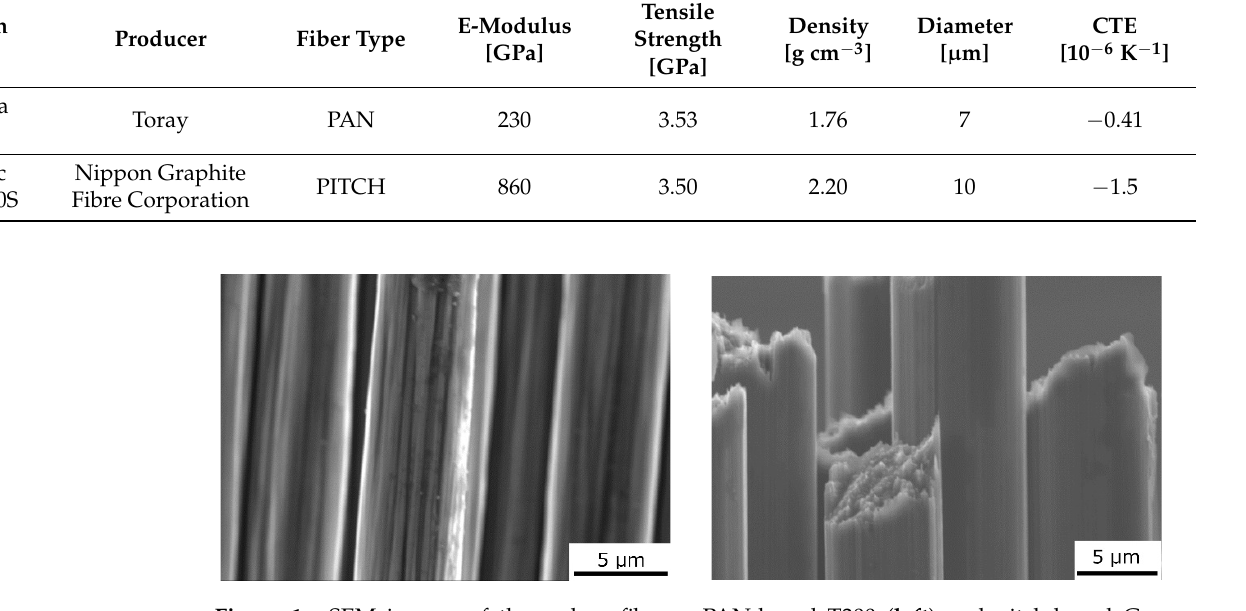
Figure 1. SEM images of the carbon fibers. PAN-based T300 ( left ) and pitch-based Granoc ( right ) fibers. Table 1. Basic data for the T300 and Granoc carbon fibers [24,25].